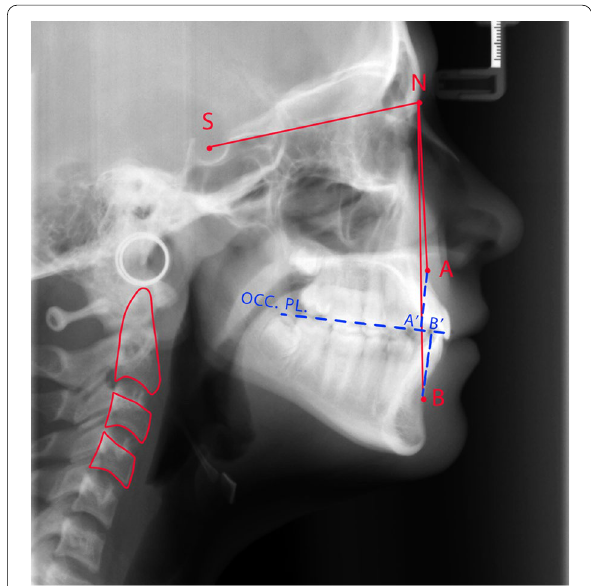
Fig. 2 An example of cephalometric tracing, illustrating the CVM stage, ANB angle, and Wits appraisal. The C2, C3, and C4 vertebrae are outlined with red color. The concave inferior border of three vertebrae alongside the horizontal rectangular shape of C3 and C4 demonstrates the CS4 stage. Sella turcica and Nasion are represented by S and N, respectively. Point A displays the deepest point on the maxilla, between the anterior nasal spine and alveolus. Point B displays the deepest point on the curvature of symphysis [23]. Two lines perpendicular to A and B points are drawn, intersecting the occlusal plane (OCC. PL.) at A ′ and B ′ . In this patient, the SNA and SNB angles were measured to be 81° and 79°, respectively. Consequently, the ANB angle was calculated to be 2°, representing a normal Class I relation. Moreover, the A ′ – B ′ distance was equal to 2 mm, confirming the ANB angle